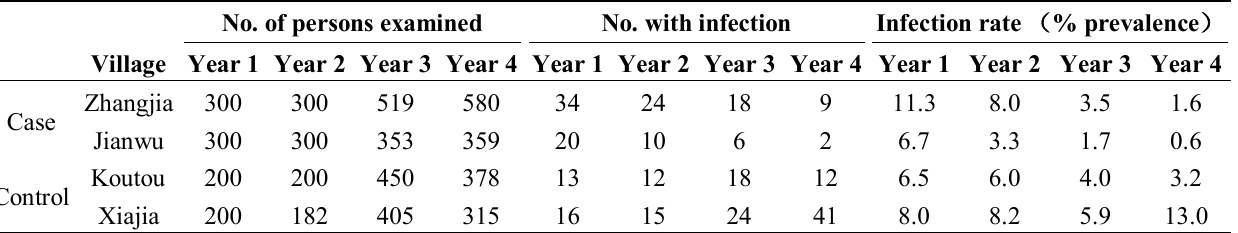
Table 2. The results of fecal examination on the population from first year to fourth